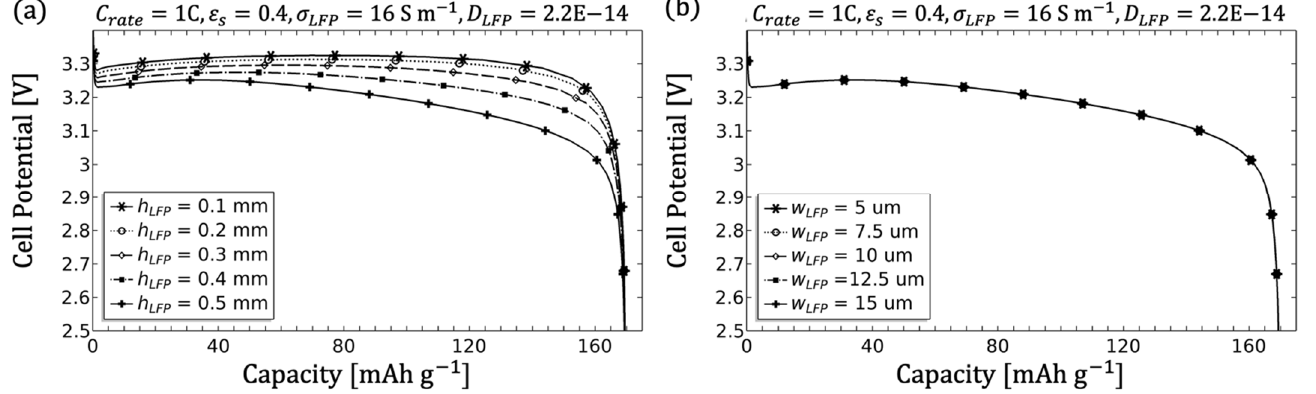
Figure 10. Parameter variation of the basic geometric variables of the LFP electrode. ( a ) shows the discharge performance related to the variation of the height (thickness). The discharge performance for the variation of the electrode width is depicted in ( b ).